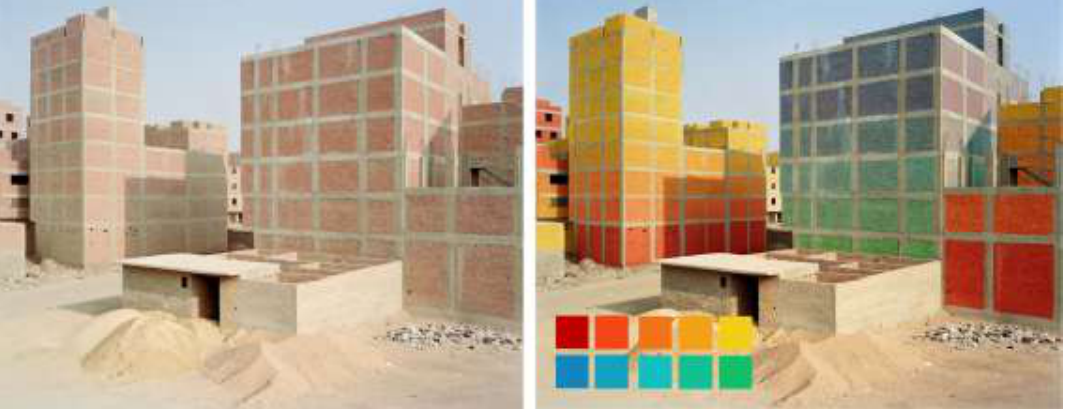
Figure 15 Concepts for tinted